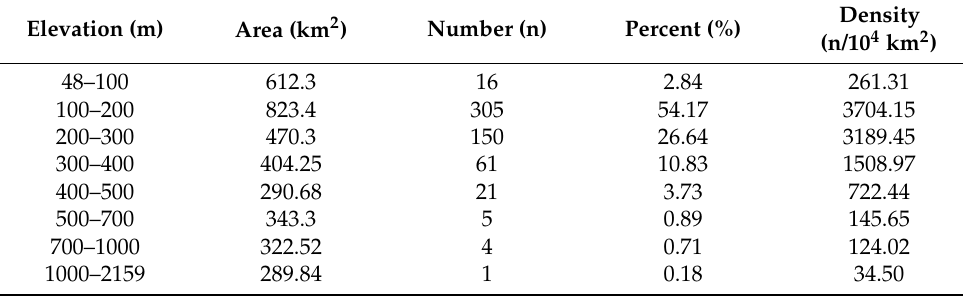
Table 1. Relationship table of settlement distribution and elevation.